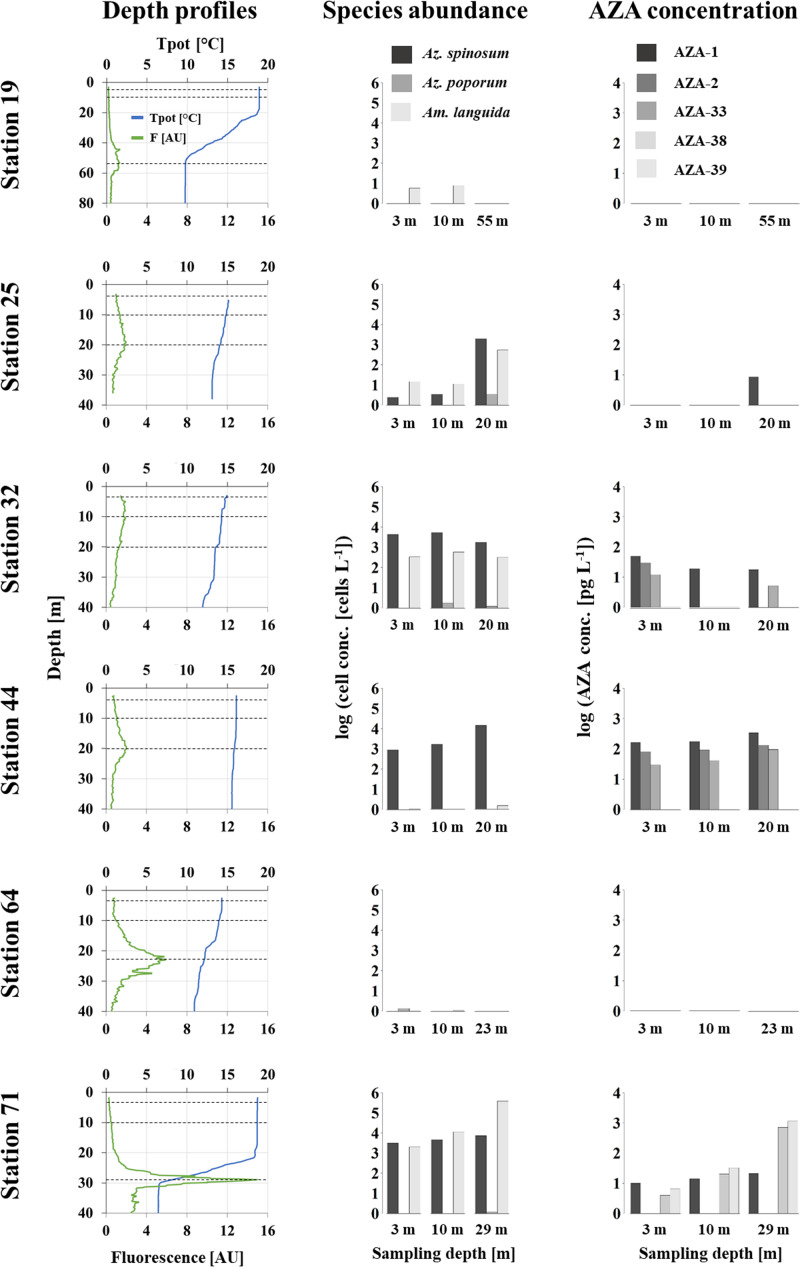
Depth (m) profiles of potential temperature Tpot (°C), fluorescence (AU), AZA-producer abundances and respective toxin quantities for six selected stations.Dashed lines in the profile plots indicate the depth for the respective samples.